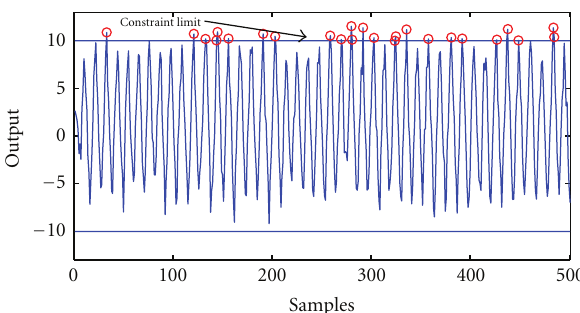
Figure 6: Base case operation with probability constraint level of 95%.